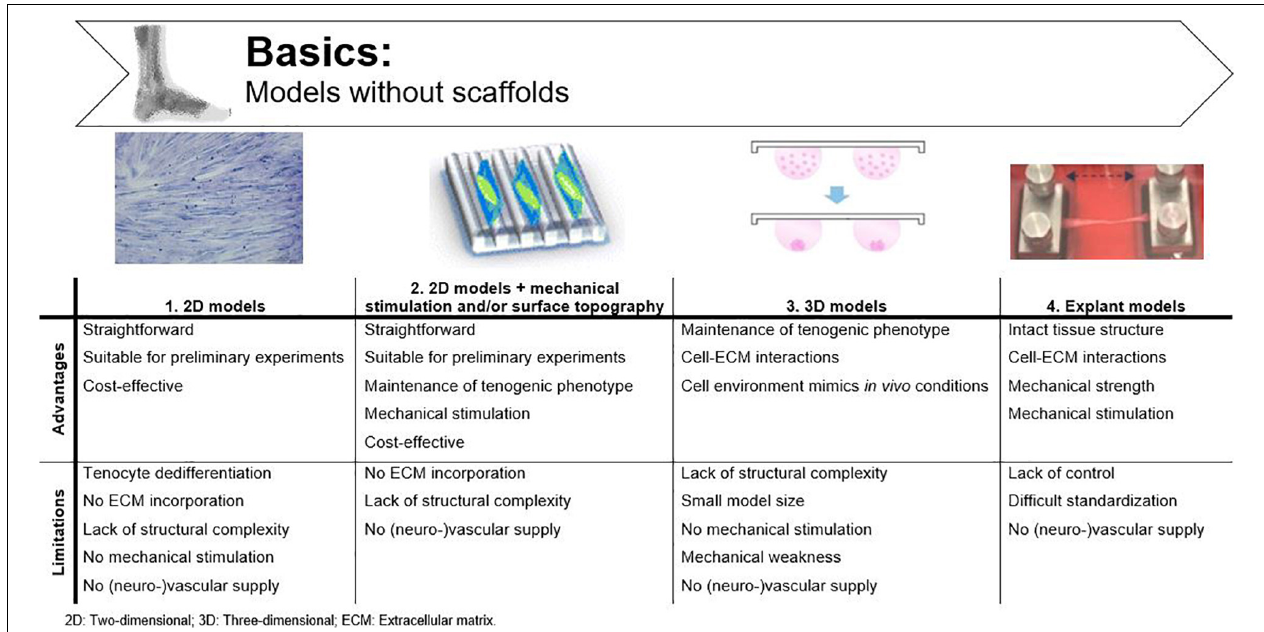
FIGURE 3 | Advantages and disadvantages of basic tendinopathy models without scaffolds. Adjusted from Krishna et al. (2016); Ryu et al. (2019) and Tohidnezhad et al. (2020).